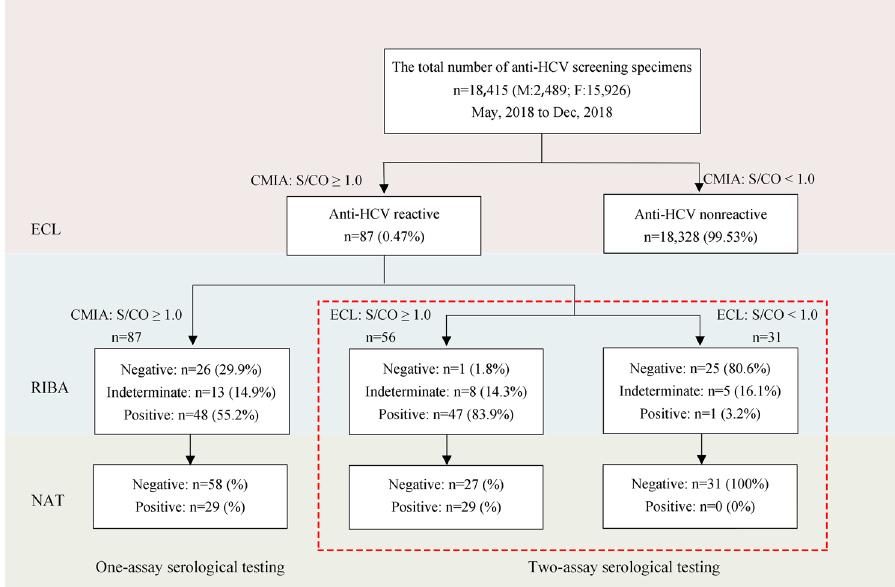
Figure 3. Schematic illustration of the HCV testing sequence for the one- and two-assay serological testing strategies (CMIA screening and ECL